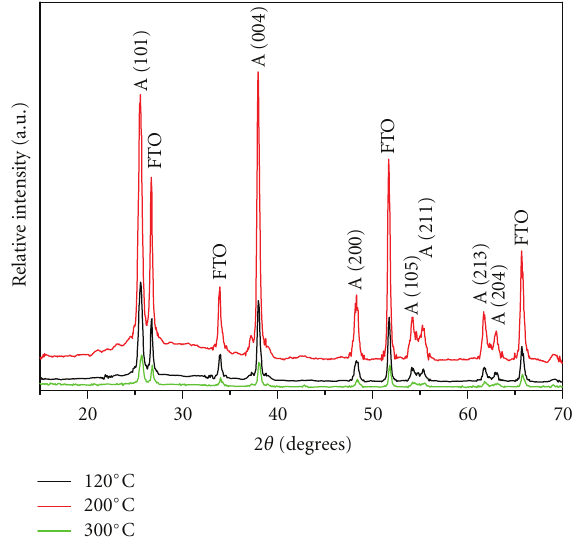
F 5: XRD patterns of MPTS-TiO nanoparticulate �lms